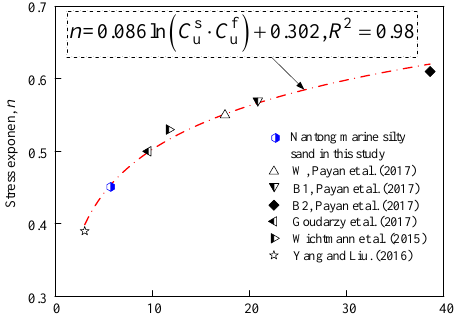
Figure 6. Variation of stress exponent n versus the synthesizing material property parameter C s